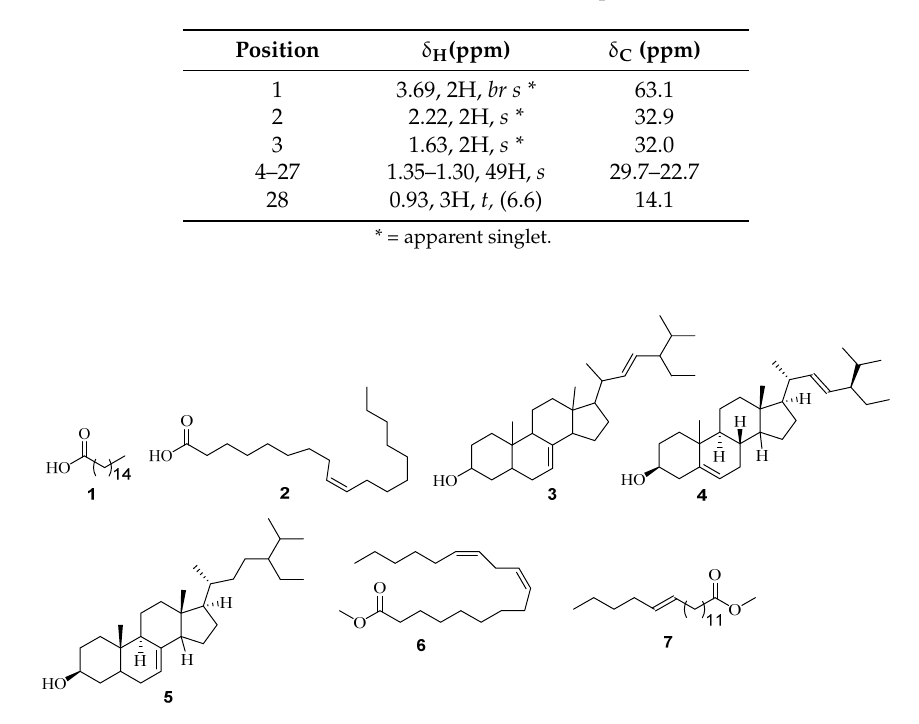
Figure 1. Structures of non-polar constituents identified from A. adianthifolia using GC-MS analysis.